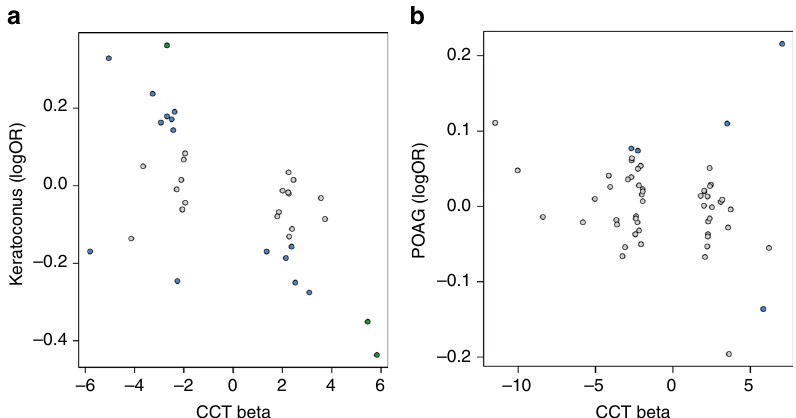
Fig. 2 Correlation of effect sizes between CCT and keratoconus and CCT and primary-open angle glaucoma. Each dot represents a CCT-associated variant. In green, variants that surpassed the Bonferroni-corrected signi fi cance threshold ( P < 5.56 × 10 − 4 ) in the keratoconus analysis ( a ). In blue, variants that were associated with a nominal level of signi fi cance ( P < 0.05) in the keratoconus or primary-open angle glaucoma analysis. In gray, variants that did not show association with keratoconus or primary-open angle glaucoma ( P > 0.05). a shows correlation of effect sizes between CCT and keratoconus, b